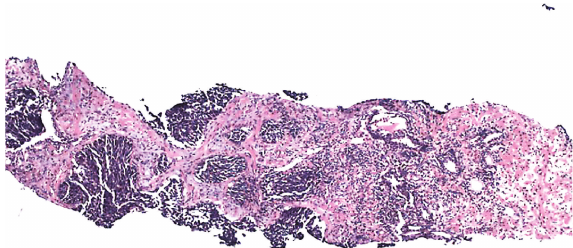
Figure 1: Low power of small cell carcinoma (left) associated with Gleason 7 acinar adenocarcinoma (right).